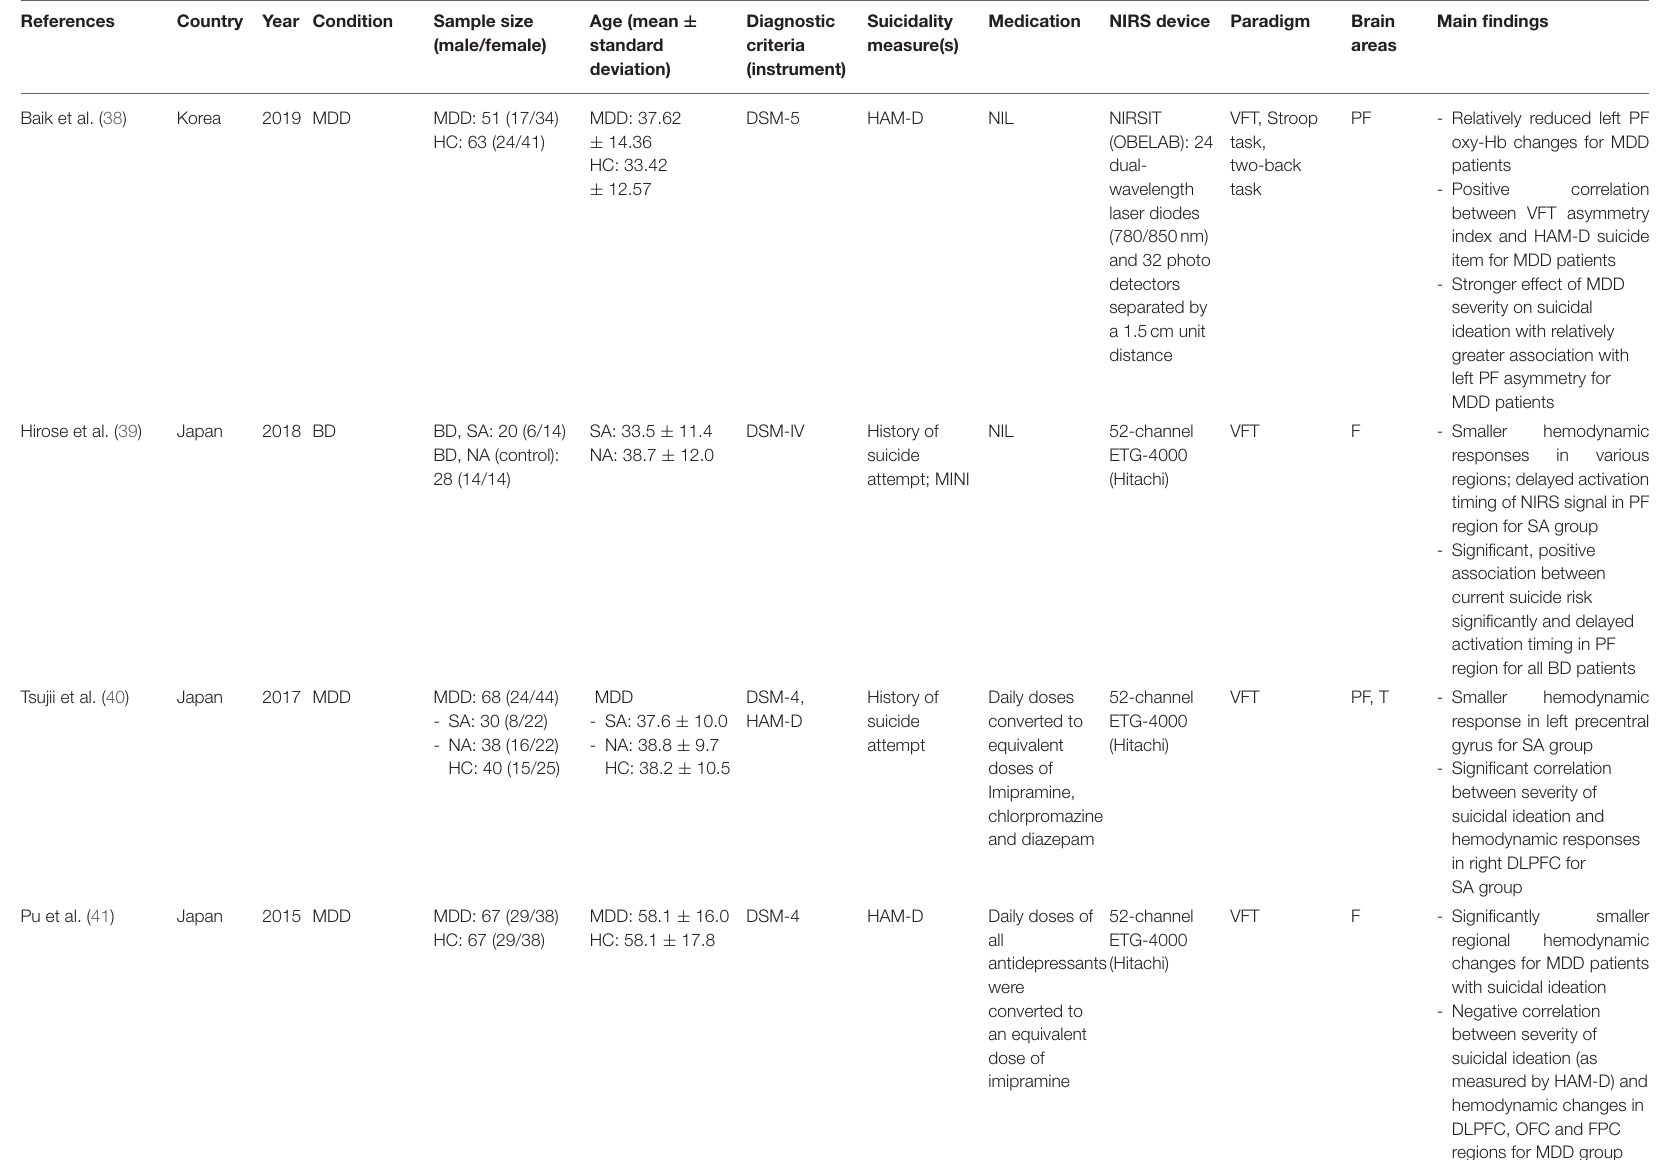
TABLE 2 | Summary of peer-reviewed studies investigating functional near infrared spectroscopy (fNIRS)-measured cerebral hemodynamic responses and their correlation with